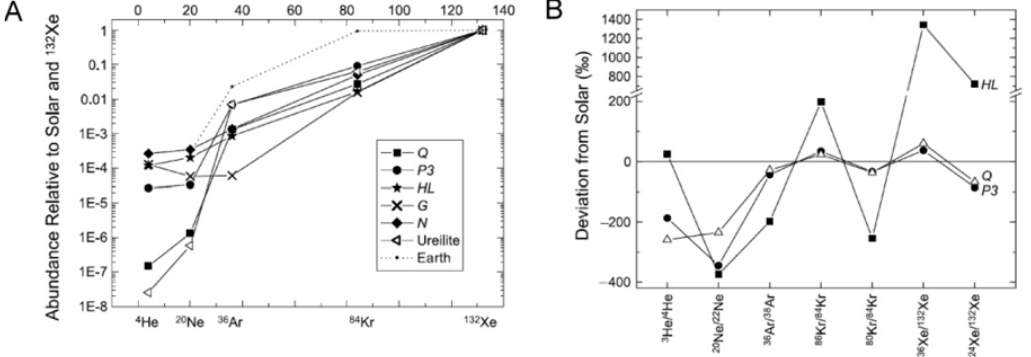
Figure 2. Elemental (A) and isotopic (B) pattern of noble gases in several reservoirs in carbonaceous chondrites, from [55]. Abundances are normalized relative to solar value and 132 Xe. Earth is presented as a reference (except He that is lost from atmosphere by dynamic escape). Isotopic patterns are characteristic of the reservoir. Etching experiments could permit the identification of the carrier phase of some of the reservoir, like presolar nanodiamonds for HL and P3. Q (containing P1 gases) is not clearly identified but may be organic. Ureilite are a class of meteorites with specific noble gases signature. G and N are trapped in SiC and presolar